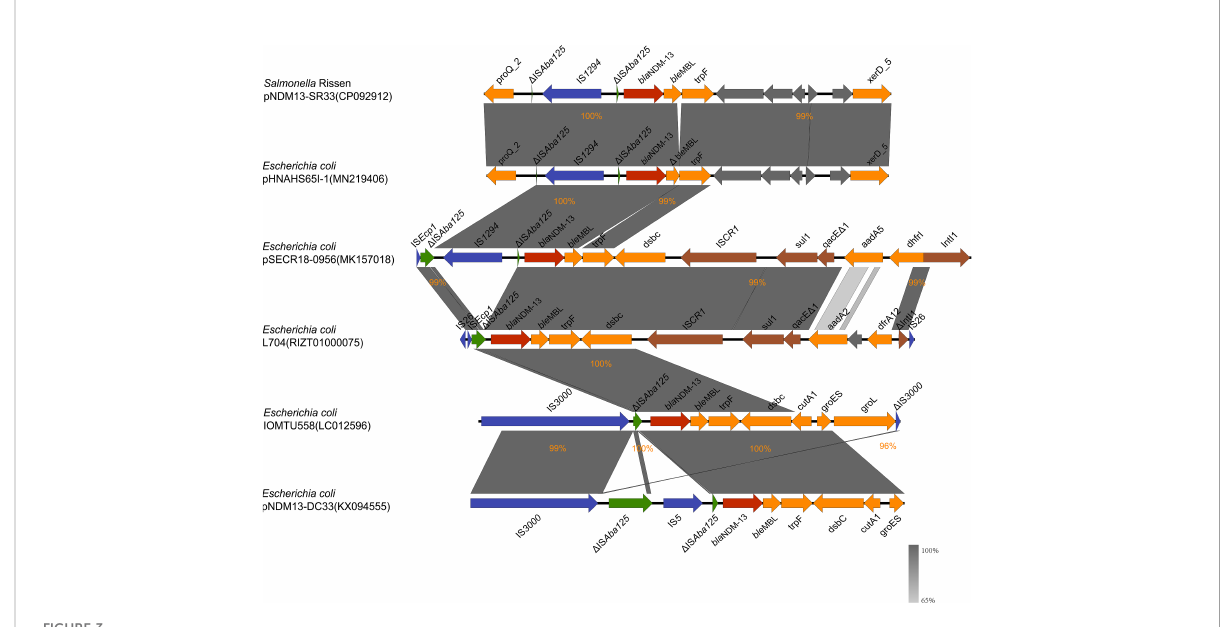
FIGURE 3 bla fl anking sequence of pNDM13-SR33 (no. CP092912), pHNAHS65I-1 (no. MN219406), L704 (no. RIZT01000075), pSECR18-0956 (no. NDM-13 MK157018), IOMTU558 (no. LC012596), and pNDM13-DC33 (no. KX094555). The bla NDM-13 gene, IS Aba125 , other insertion sequences, integron elements, and genes encoding hypothetical proteins are shown in red, green, blue, brown, and gray, respectively. The rest of genes are colored in orange. D ; indicates a truncated gene or mobile element. The percentages signify the genetic identity between these